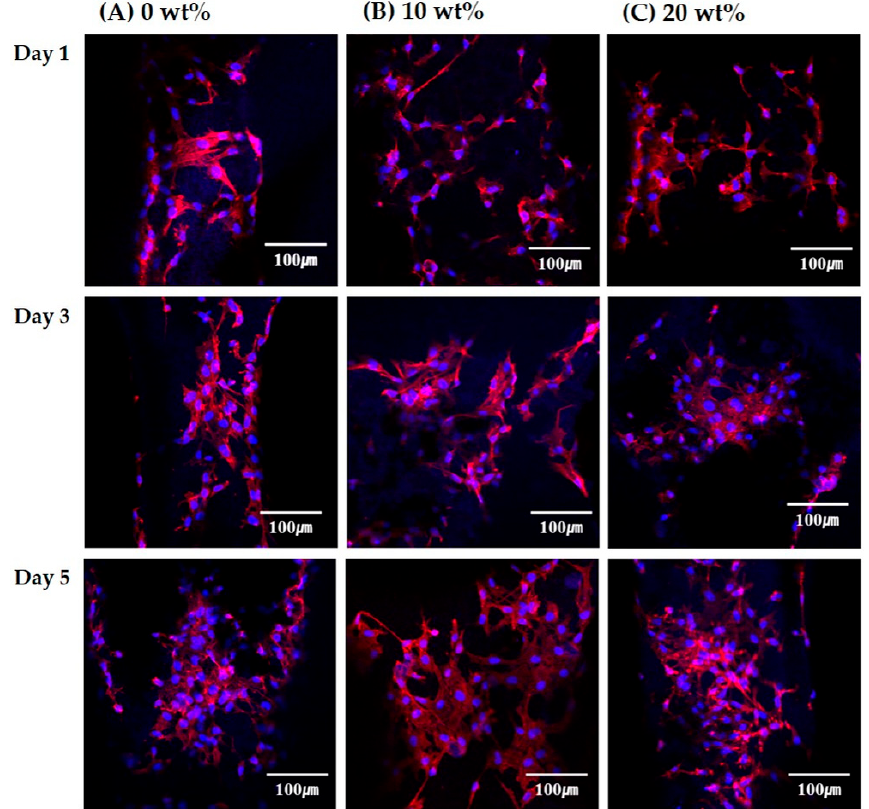
Figure 9. Representative confocal laser scanning microscopy (CLSM) images of the MC3T3-E1 cells on the hierarchical macro/micro-porous PCL–CaP composite scaffolds produced using various CaP contents of ( A ) 0 wt%, ( B ) 10 wt%, and ( C ) 20 wt% at 1, 3, and 5 days.